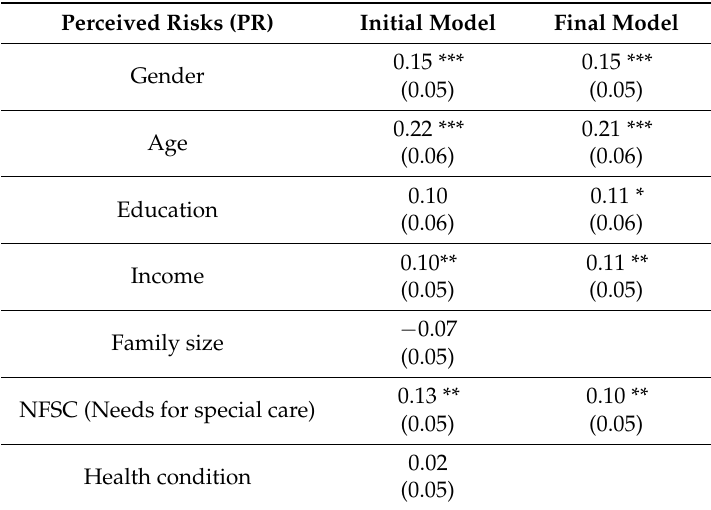
Table 5. The estimated structural